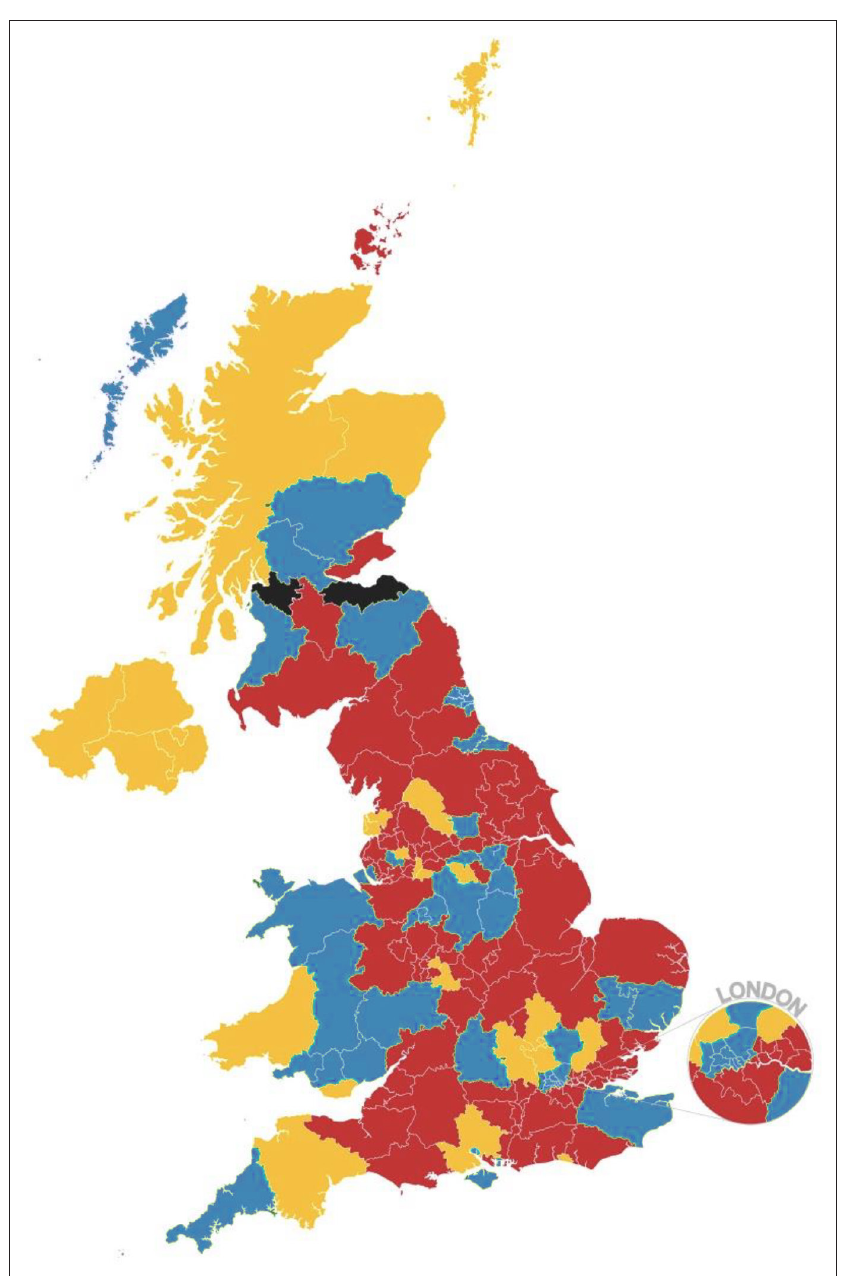
Figure 1 The availability of clinical commissioning group or health board- endorsed community liver pathways in the